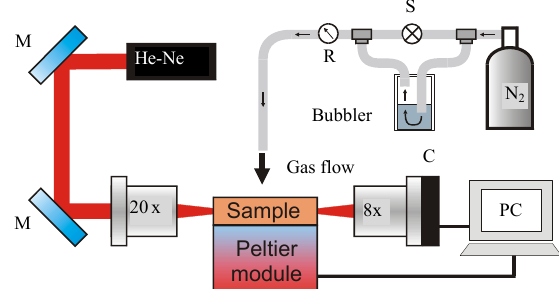
Fig. 2 Schematic illustration of waveguide device testing scheme. From a He-Ne laser the light is coupled into the Peltier module temperature stabilized sample using two mirrors M and a microscope objective, the output light intensity is collected on a camera C. The N 2 gas can be pumped through a bubbler with solvent or delivered directly to the sample depending on the switch S position. The gas flow is monitored by a rotameter